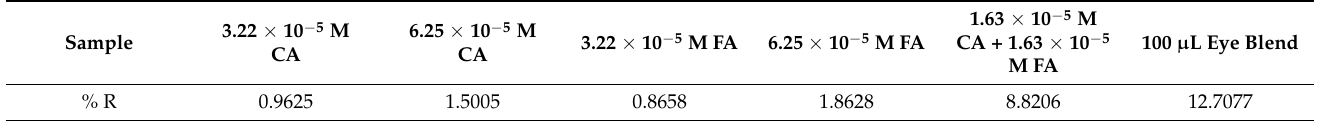
Table 6. Determination of the antioxidant activity of CA and FA